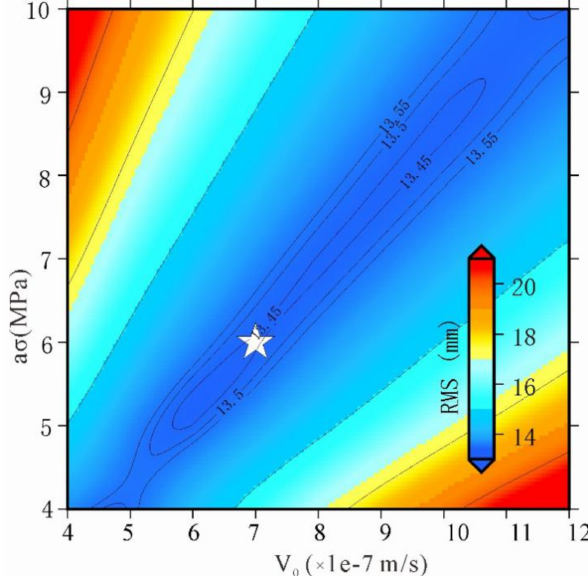
Figure 12. Searching for the optimal parameter value of the stress-driven afterslip model, the white pentagram represents the optimal value.